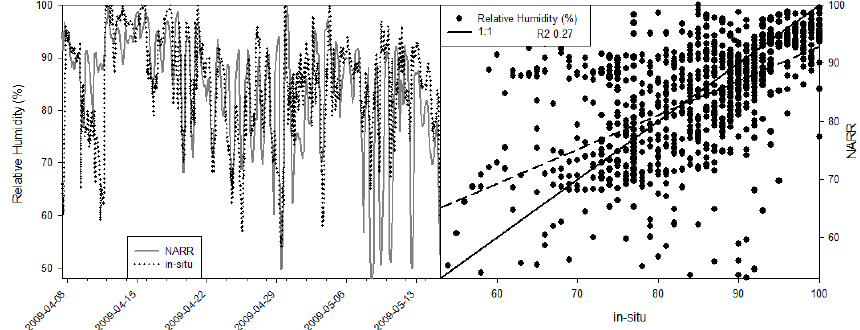
Figure 3. Relative humidity (%) for the observation period, and the relationship between NARR and in situ values.